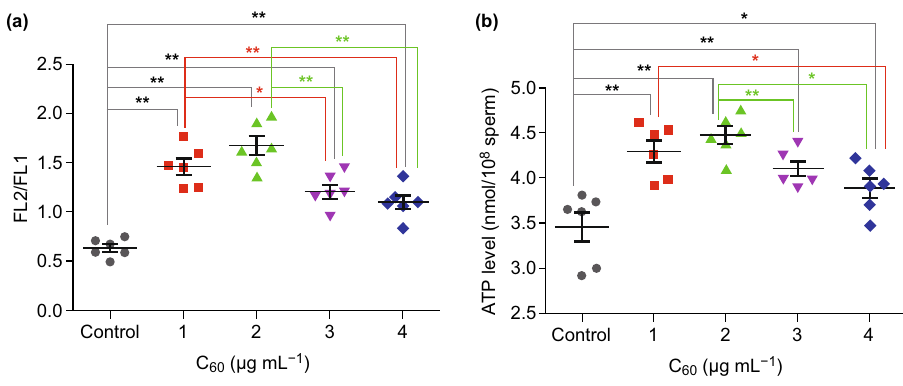
Fig. 3 Dot plots of the mitochondrial membrane potential and ATP in the control and treatment groups after 15 days of treatment. a Mitochon- drial membrane potential, b ATP level (n = 6, * P < 0.05, ** P <